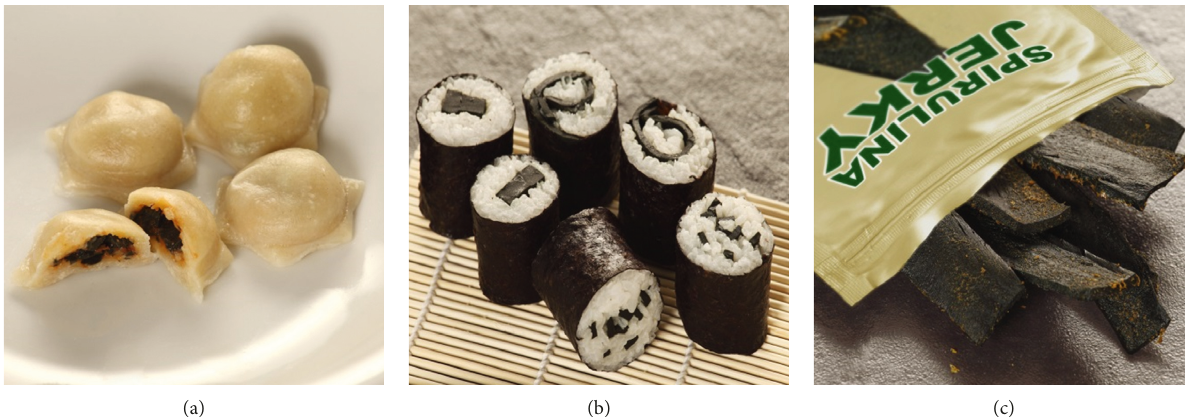
Figure 1: Pictures of spirulina-filled pasta (a), spirulina-filled sushi (b), and spirulina jerky (c) as they were shown to the consumers. The verbal benefits can be found in Table